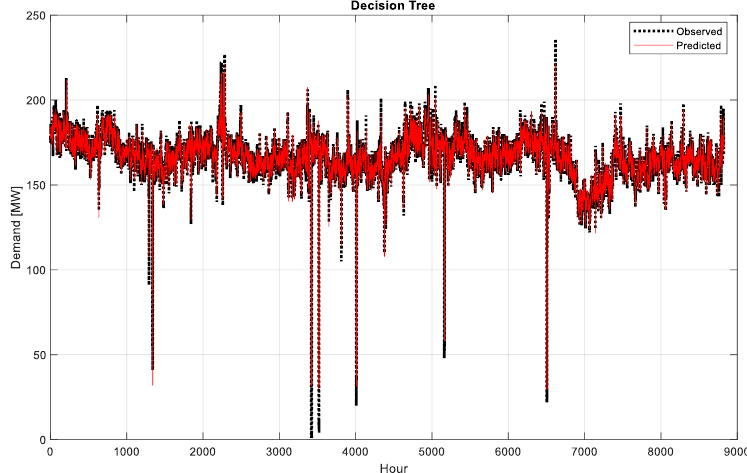
Figure 9. The ESC demand Forecasting using the Decision Tree model optimized using BO.